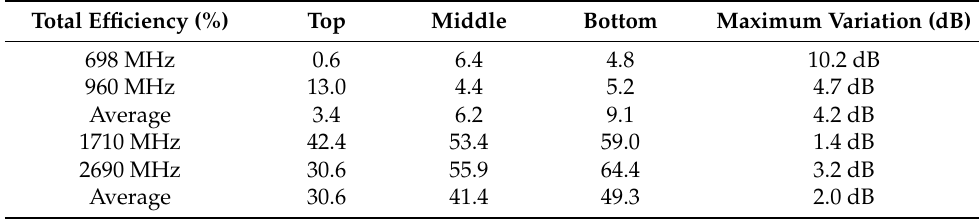
efficiency value for a given position over the minimum total efficiency